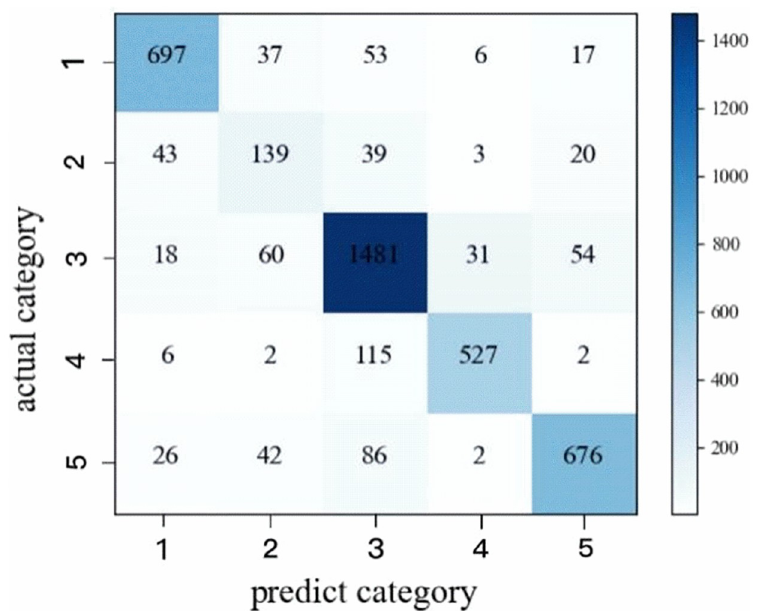
Fig 7. Confusion matrix of Sleep-EDF data